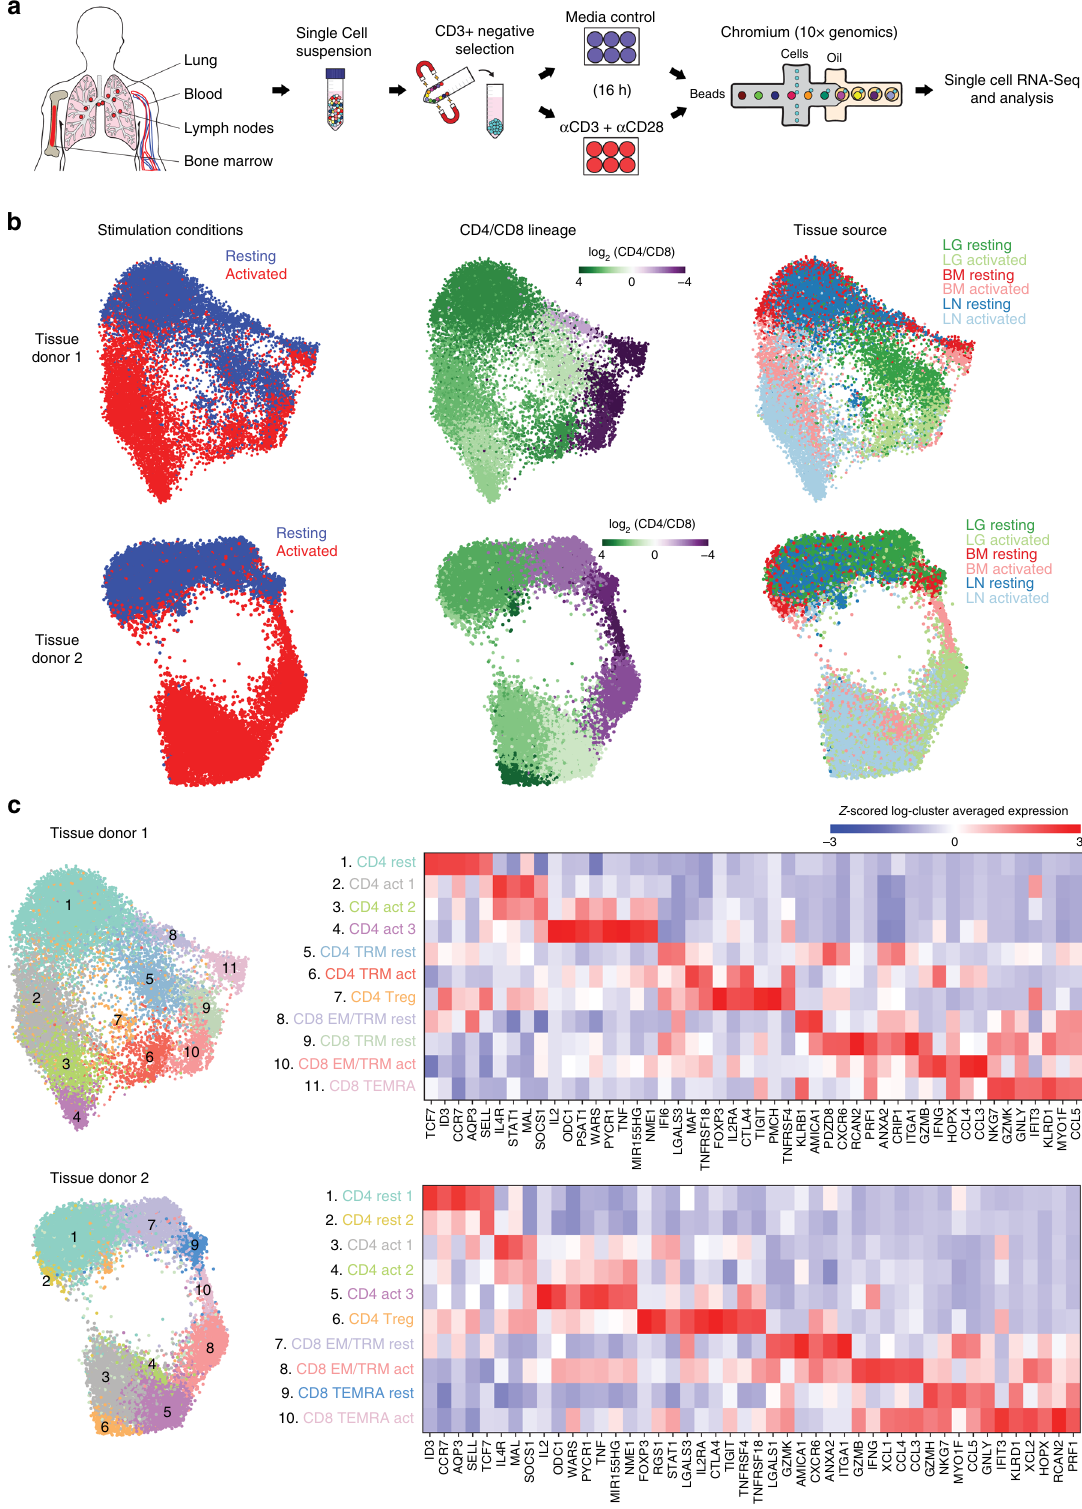
onto the UMAP embeddings of T cells from each tissue donor (Fig. 2a, b). The majority of blood T cells co-localized with resting or activated T cells from BM but did not exhibit substantial overlap with LG or LN T cells from either donor, particularly in the resting state (Fig. 2a, b). We also quanti fi ed the number of